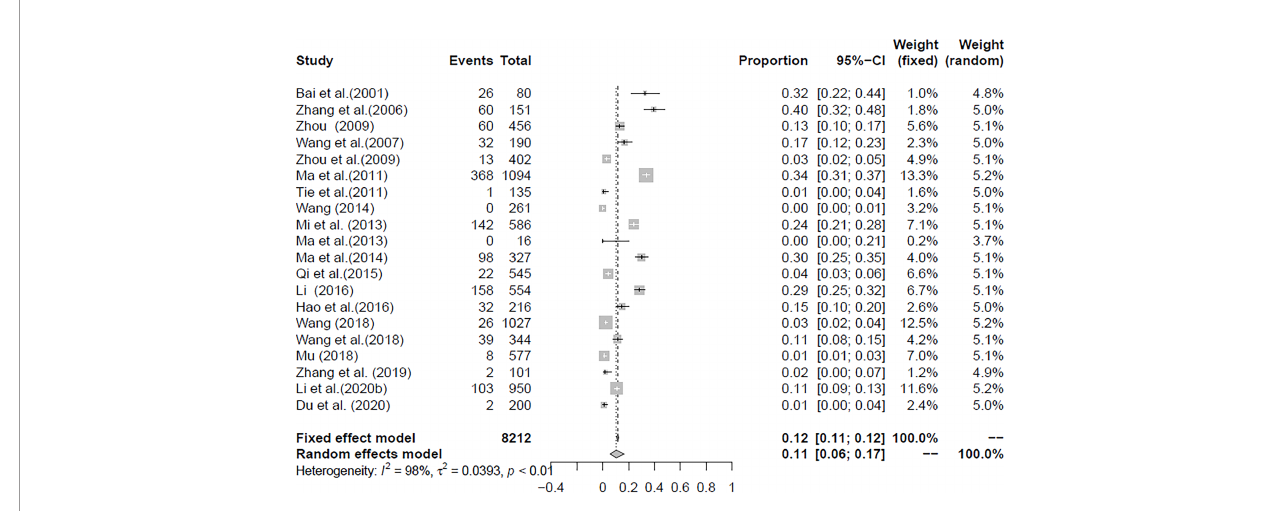
FIGURE 3 | Forest plot of Cryptosporidium prevalence in yaks in China.